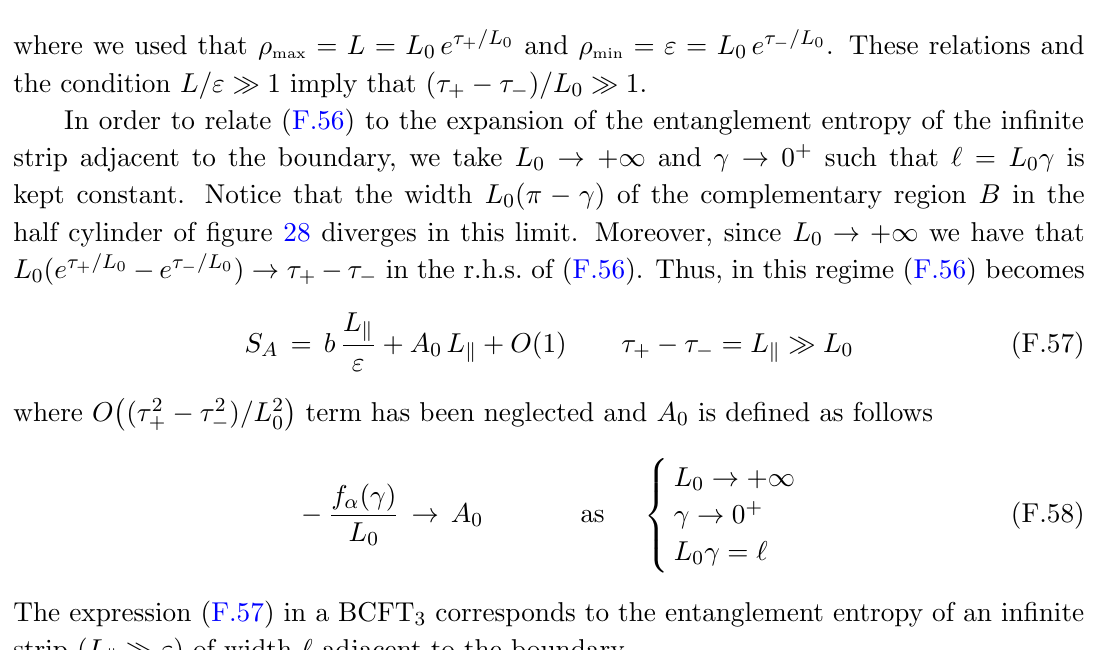
Figure 28 . Part of the surface of a half cylinder, introduced in the appendix F.5 (see d ~ s 2 in (F.54) for (cid:31) = (cid:25)= 2). This surface corresponds to the conformal boundary of the gravitational spacetimes depicted in (cid:12)gure 29. The yellow region is an in(cid:12)nite strip A adjacent to the